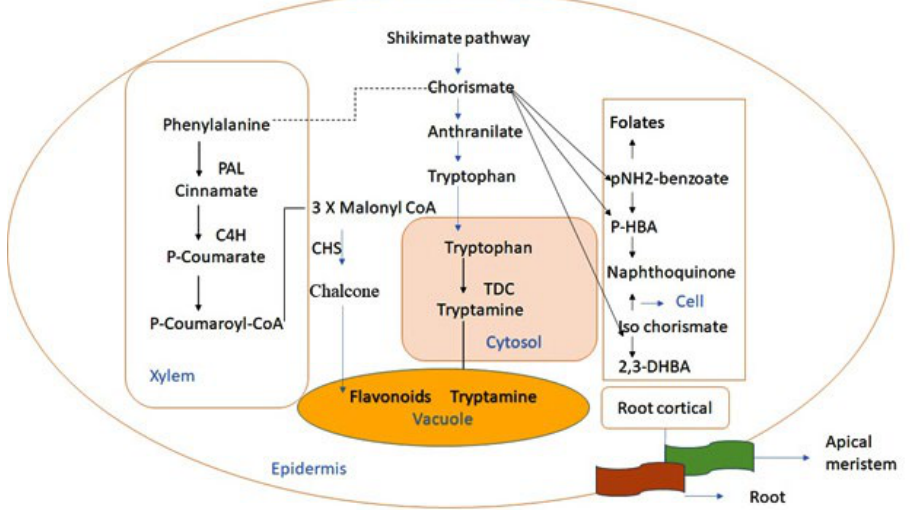
Fig. 2. The shikimate chorismateindole pathway and its division at the intercellular and subcellur levels. The solid arrow represent a one step reaction; broken arrows represent multiple reactions or unidentified